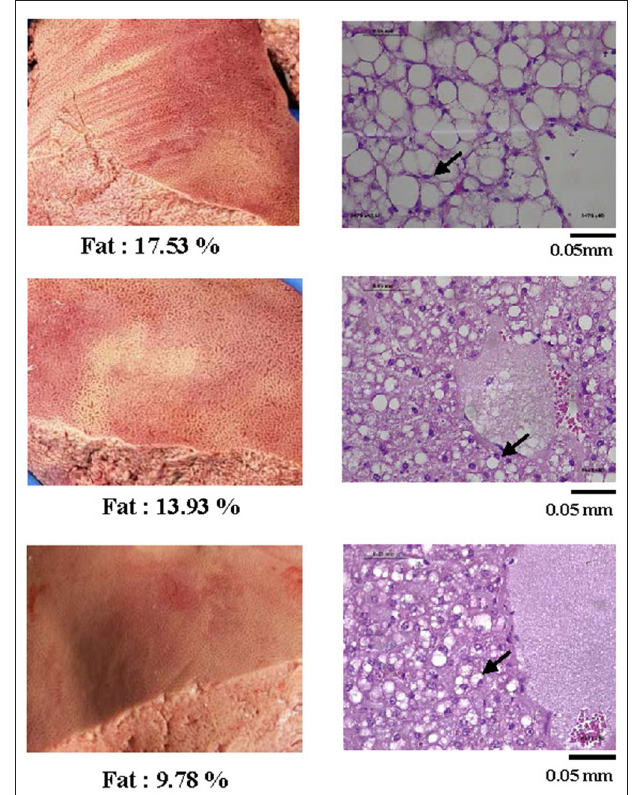
FIGURE 2 | Representative pictures of livers from sheep with pregnancy toxemia (left) and corresponding histological photographs (right) of tissue sections stained by PAS at a 400X magnification. All livers of PT-affected ewes were yellowish and of fragile texture. The histopathology analysis revealed extensive micro and macrovesicular steatosis. Arrows exemplify nuclei pushed aside by large hepatocyte lipid